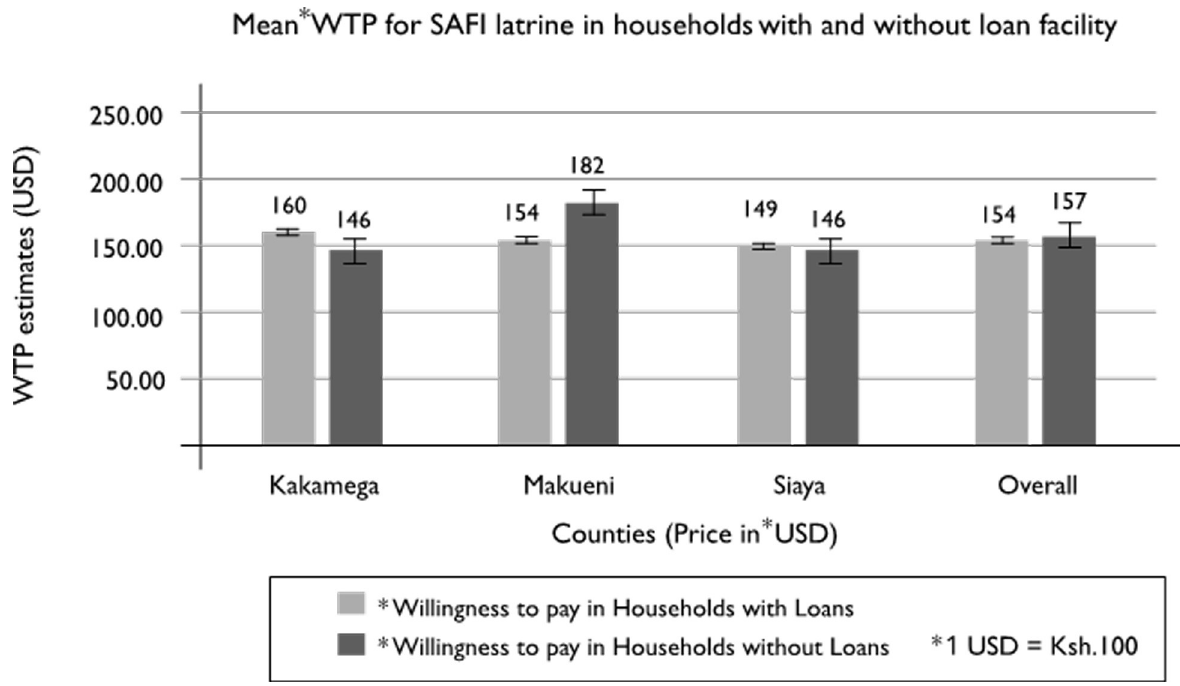
Fig 7. Mean Willingness to pay for SAFI latrines amongst households with/without finance.